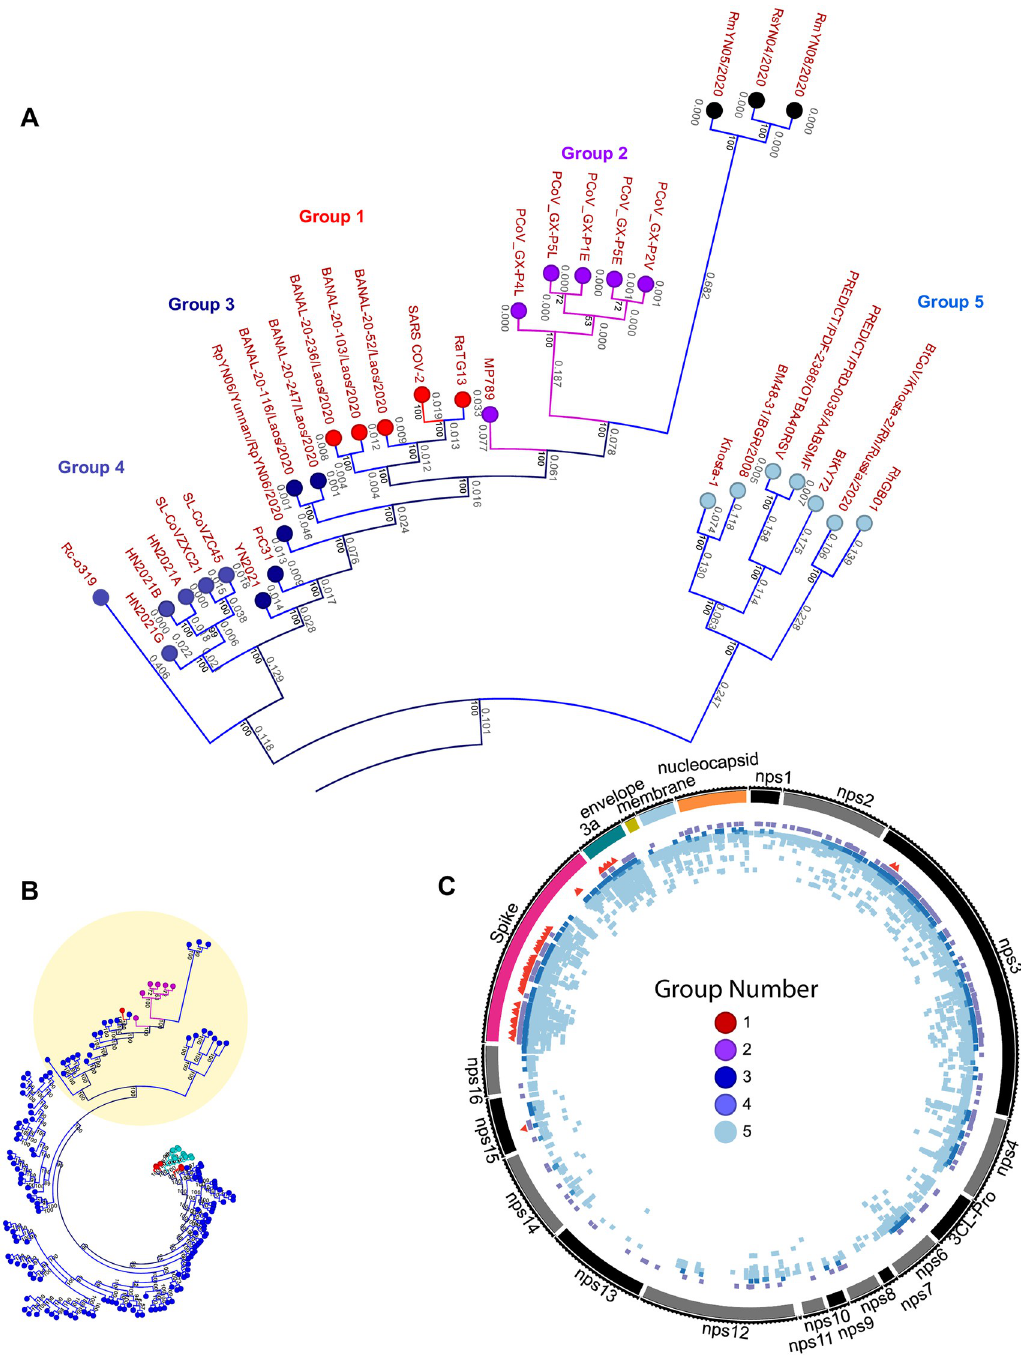
Fig 2. The distribution of covariant residues in CoVs most closely related to SARS-CoV-2. (A) the identification and CoVs in Groups 1–5 in a subset of the maximum likelihood tree showing branch length and bootstrap values. (B) Position of tree subset in entire maximum likelihood tree (from Fig 1B). (C) Distribution of covariant residues in core genes for Groups 1–5 based on clusters specific to each group. Each group is indicated by color and the position of every residue is colored.